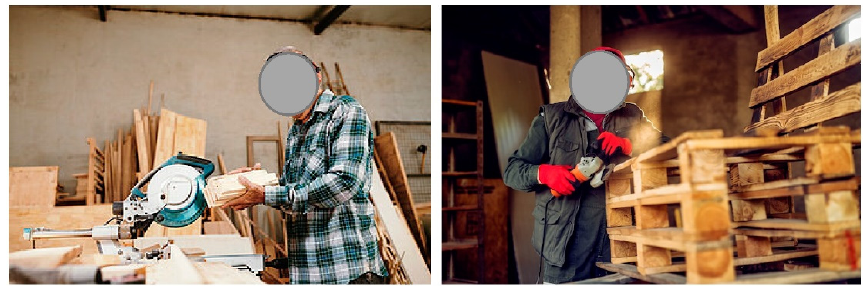
Figure 1. Examples of a senior worker in wood